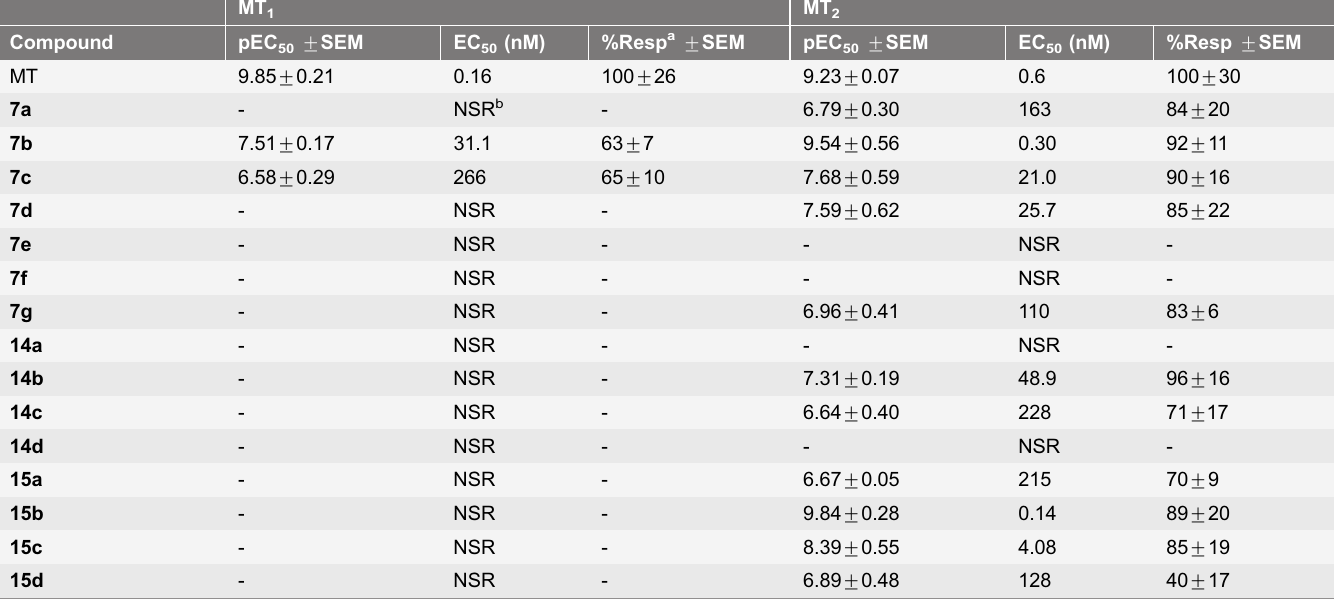
Table 2. Isoquinolinone-induced intracellular Ca 2 + mobilization in MT 1 -CHO and MT 2 -CHO cells. MT 1 MT